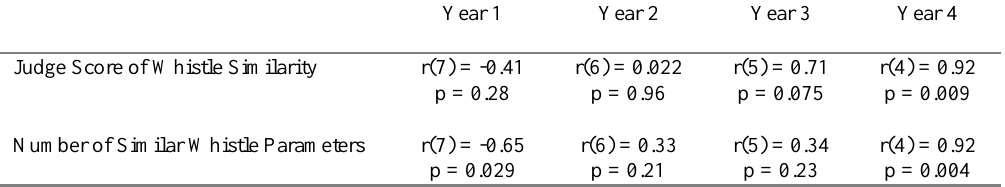
Correlations Between COAs and Whistle Similarity in Mother-Offspring Pairs by Age of the Calf